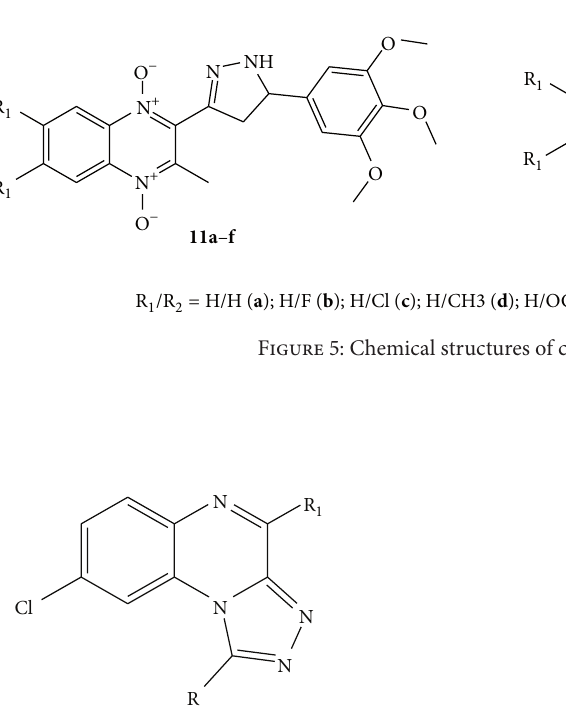
Figure 6: Chemical structures of compounds 13a – j .